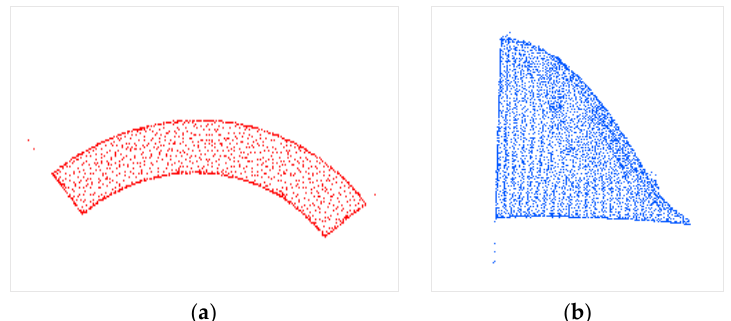
Figure 14. Outer points are extended to regular surfaces in the fandisk model: ( a ) plane; ( b ) cylindrical surface.